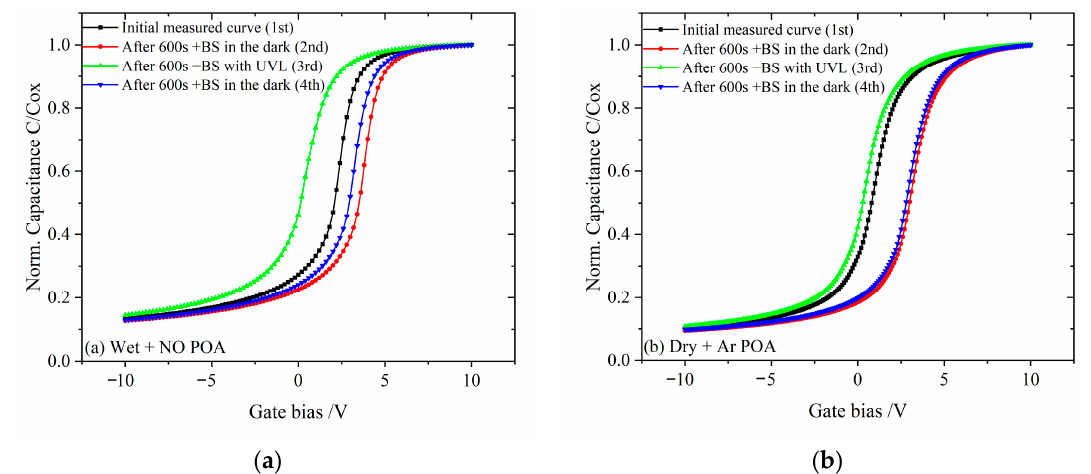
Figure 7. Typical C-V characteristics measured at 10 kHz in the dark before and after positive and negative time-dependent bias stress (BS) with UVL irradiation for the ( a ) H&N hybrid and ( b ) Ar passivation samples.